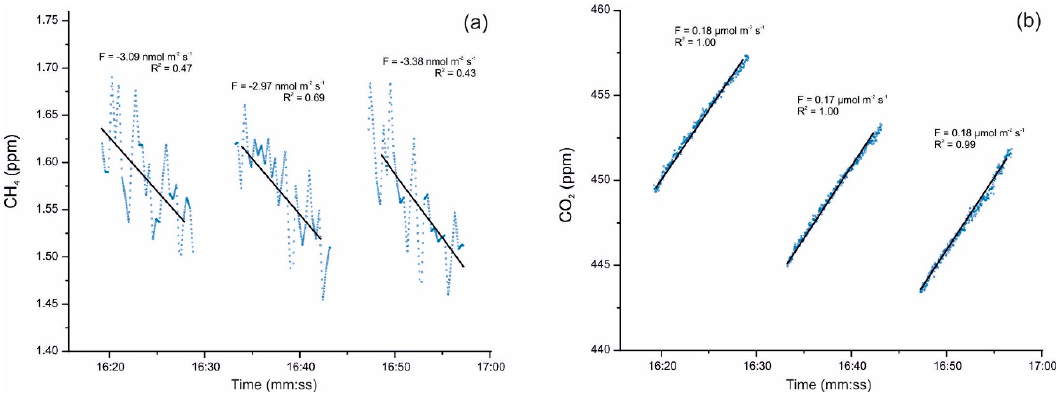
Figure 2. ( a ) Detail of CH 4 uptake fluxes with an average of − 3.15 nmol m − 2 s − 1 and ( b ) simultaneous CO 2 emission fluxes uptake fluxes with an average of +0.17 µmol m − 2 s − 1 , monitored on 17